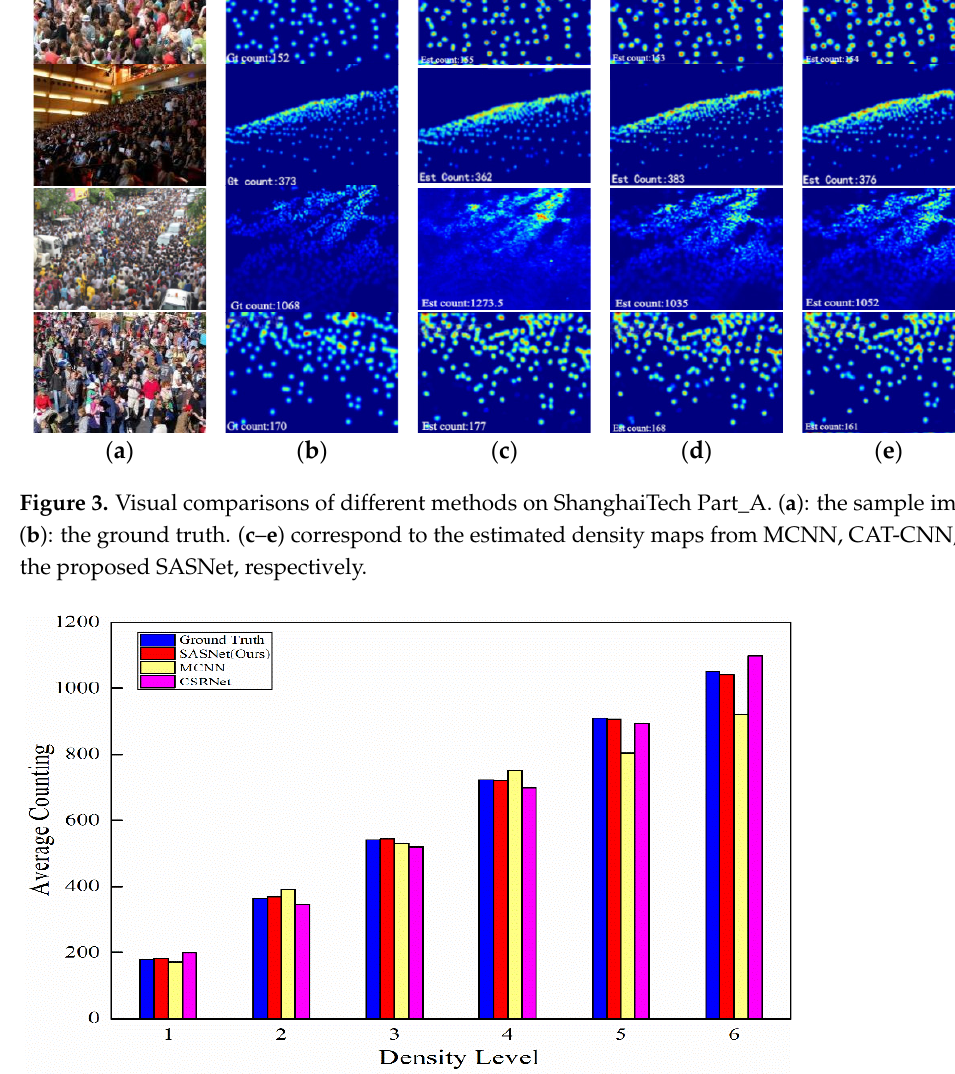
Figure 3. Visual comparisons of different methods on ShanghaiTech Part_A. ( a ): the sample images. ( b ): the ground truth. ( c – e ) correspond to the estimated density maps from MCNN, CAT ‐ CNN, and the proposed SASNet, respectively.